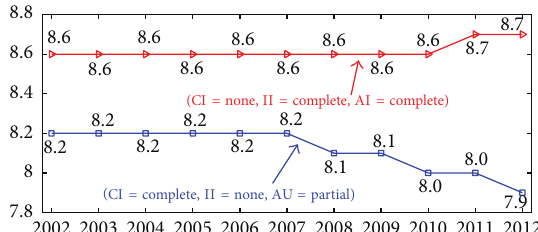
Figure 7: Impact subscore curves from 2002 to 2012 for two vulnerability types; the impact of a vulnerability changes when V (𝑡) increases over time.